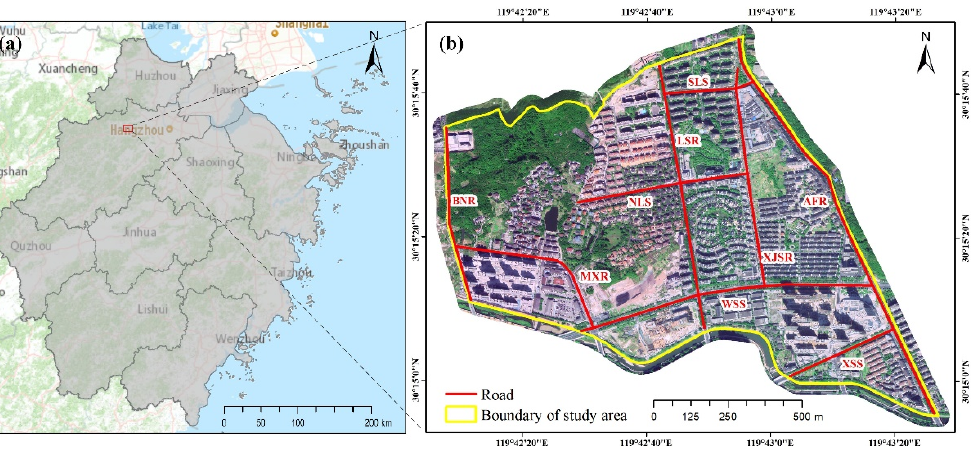
Figure 1. Location of the study area. AFR, Agricultural and Forestry Road; SLS, Shuanglin Street; LSR, Linshui Road; NLS, Nonglin Street; WSS, Wusu Street; XSS, Xishu Street; MXR, Maxi Road; XJSR, Xijingshan Road; BNR, Baini Road. ( a ) Zhejiang Province ( b ) Study area.